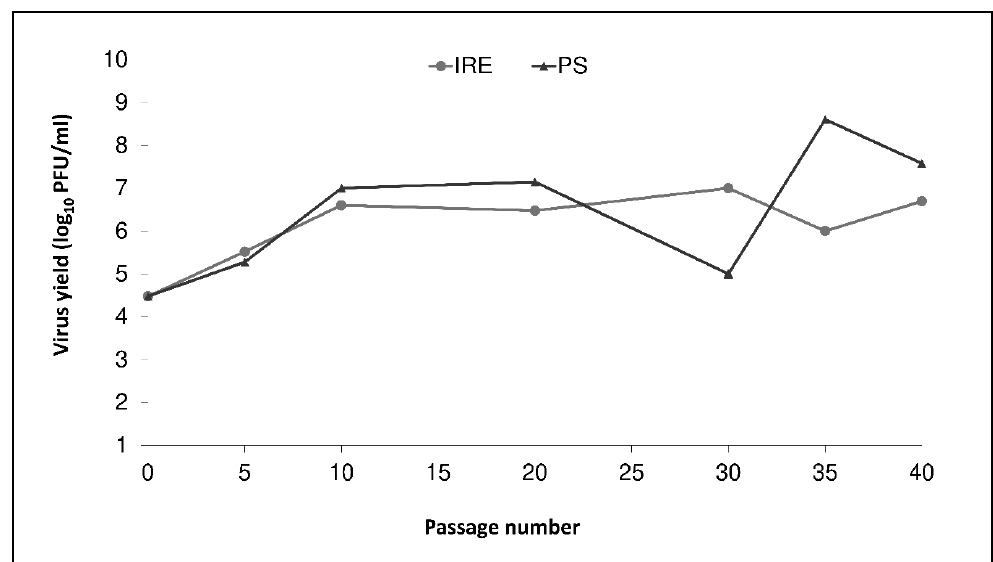
Figure 1. Viral replication kinetics during serial passages of tick-borne encephalitis virus parental strain Hypr in mammalian porcine kidney cells (PS) (dark line with triangles) and in the tick cell line IRE/CTVM19 (light line with circles). The titer was determined using plaque assay and viruses were sampled once at the indicated passage levels per virus variant.